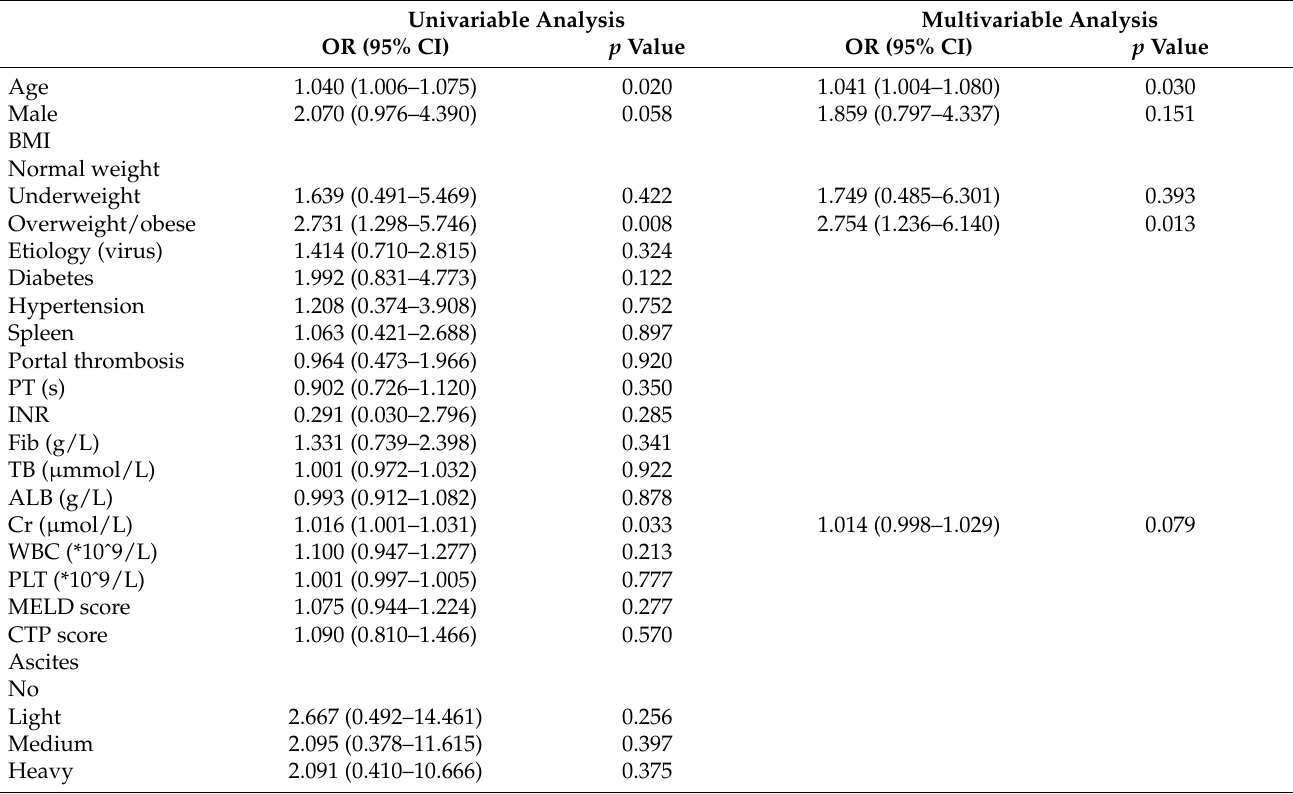
Table 3. Logistic regression analysis of the risk factors for post-TIPS OHE. Univariable Analysis Multivariable